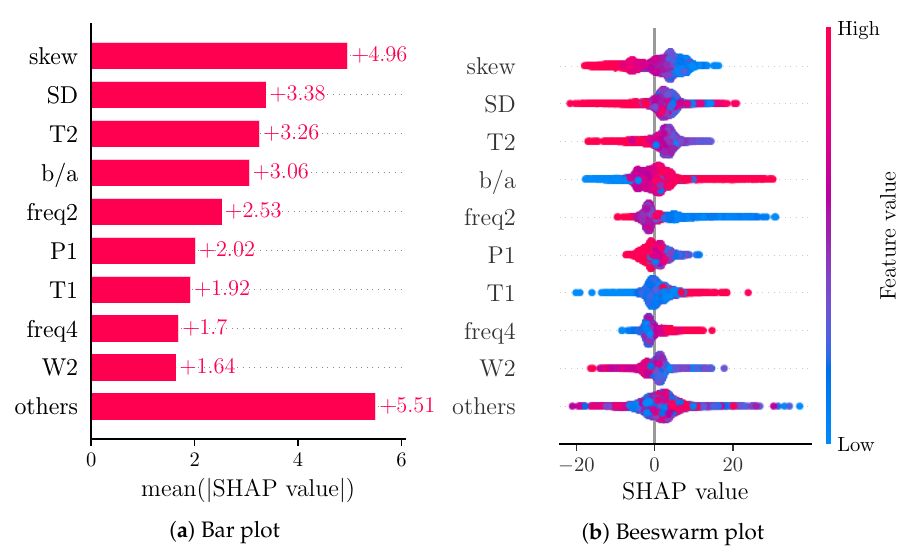
Figure 3. ( a ) shows a bar plot of mean absolute SHAP values that indicates global feature importance (mean absolute for each feature over all given samples). ( b ) depicts a beeswarm plot of SHAP values. For each sample, this plot shows a dot on each feature row. The features are ordered according to the mean absolute SHAP values for each feature. Depicted are the nine features with the highest mean absolute SHAP value and the sum of the remaining